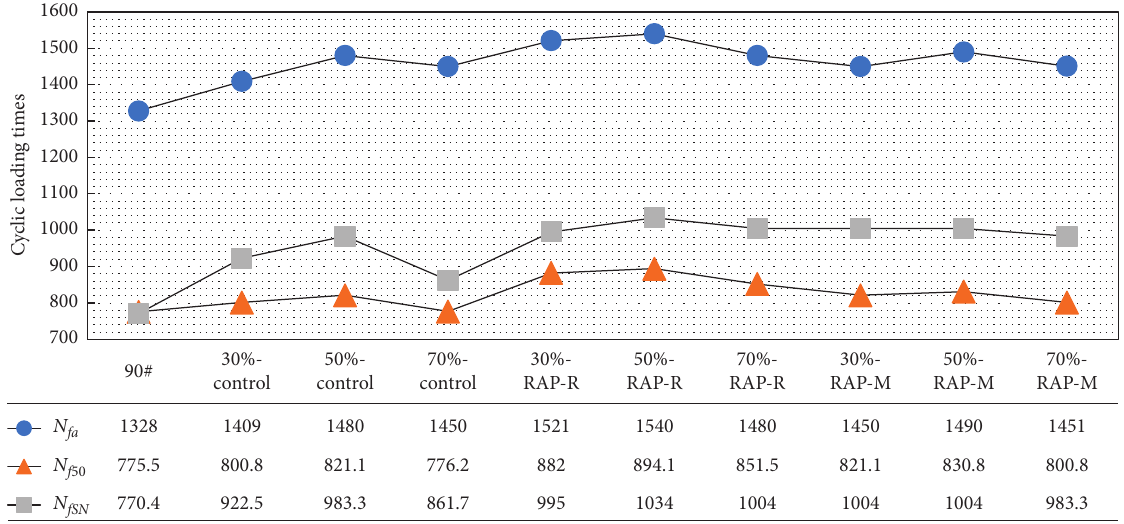
Figure 26: Fatigue life results of the three